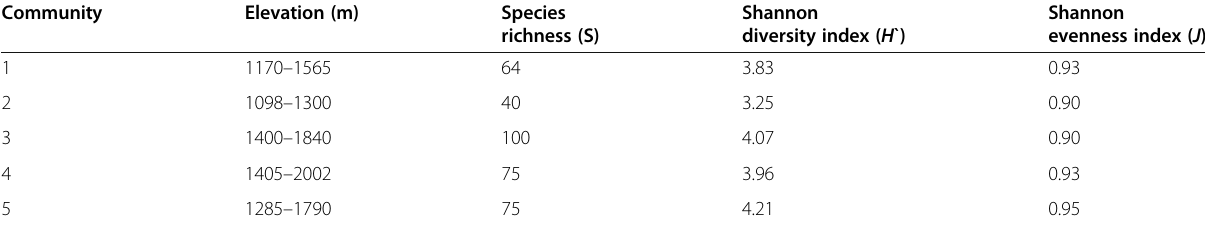
Table 3 The Shannon diversity and evenness indices for the five communities Community